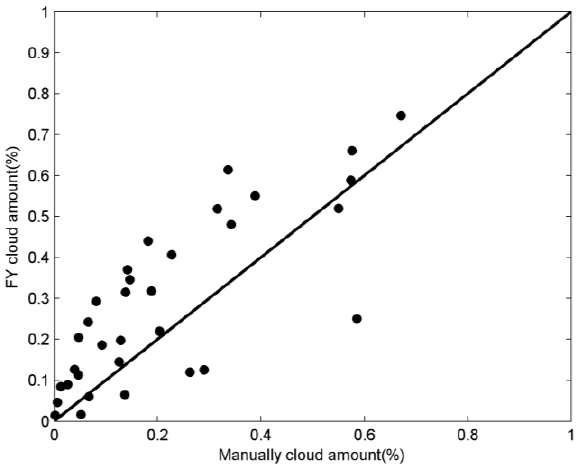
Figure 3. Comparison of cloud amount between FY